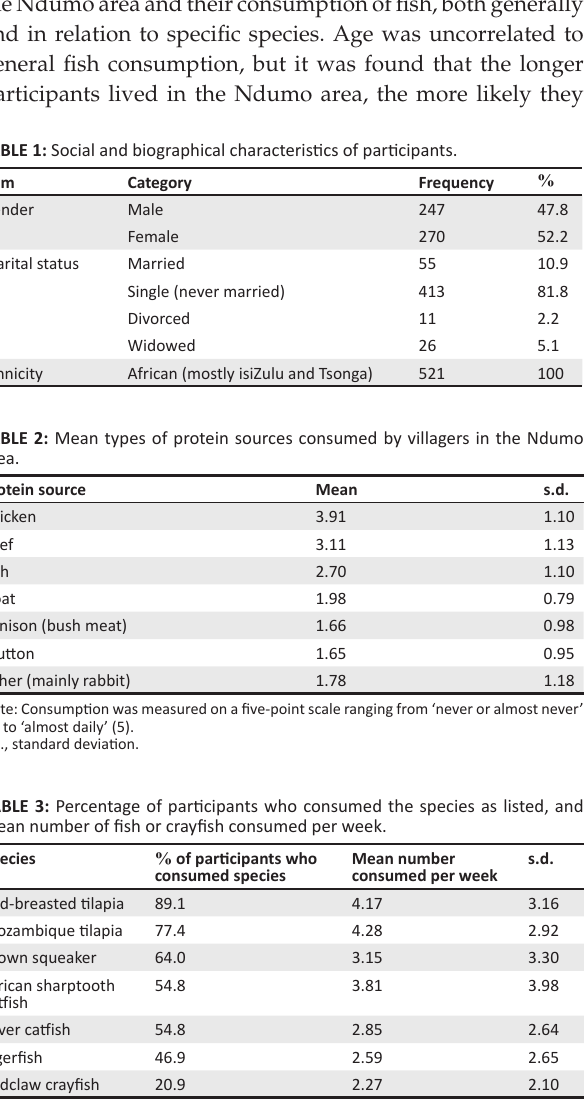
Redclaw crayfish TABLE 4: Summary of type of species caught, and number of each species caught in an average week. Species Percentage of participants who actively caught this species